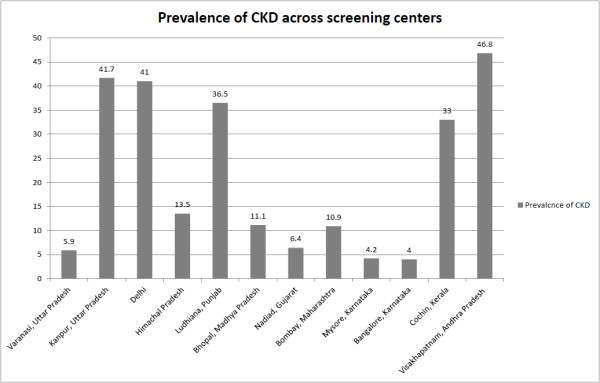
Prevalence of CKD across screening centers.